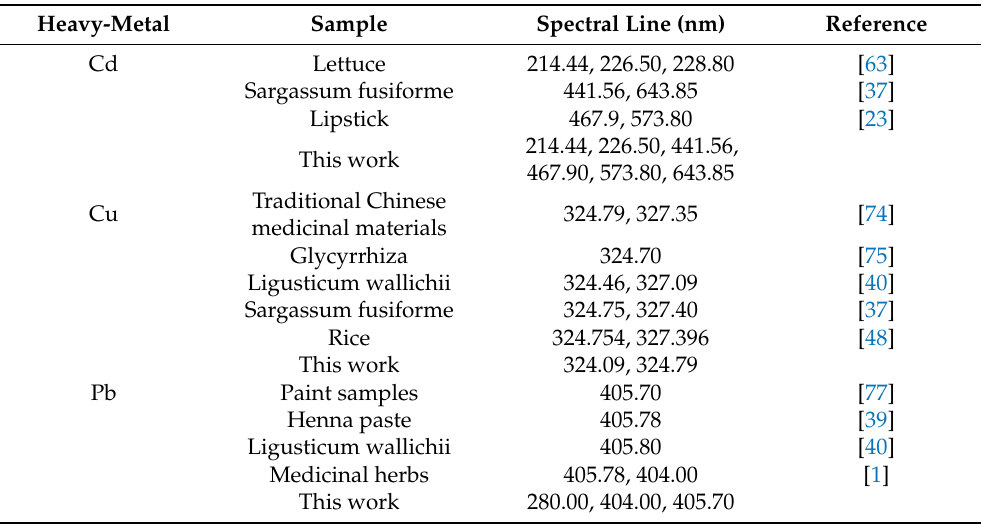
Table 4. Results of some recent heavy metals (Pb, Cd and Cu) detection using LIBS of various samples and current